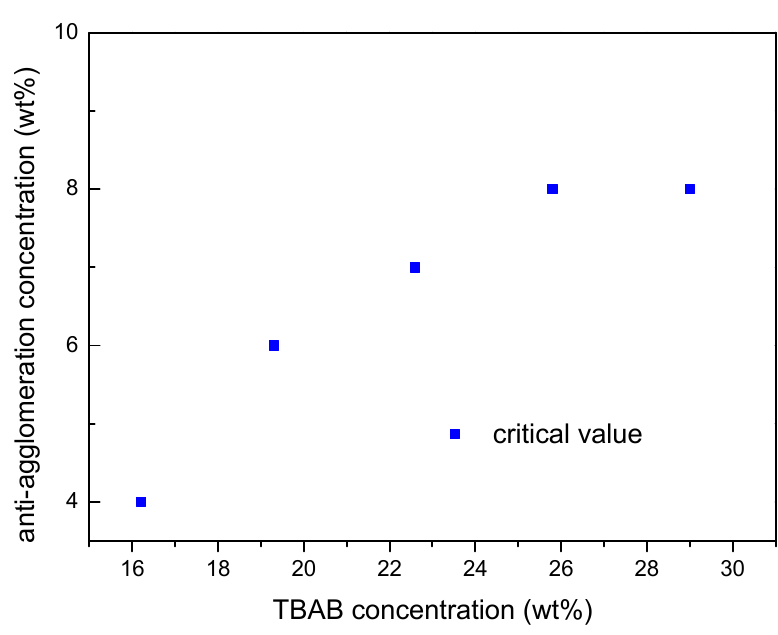
Figure 3. AA ′ s critical minimum concentration for different TBAB solutions. Figure 3. AA (cid:48) s critical minimum concentration for different TBAB solutions.